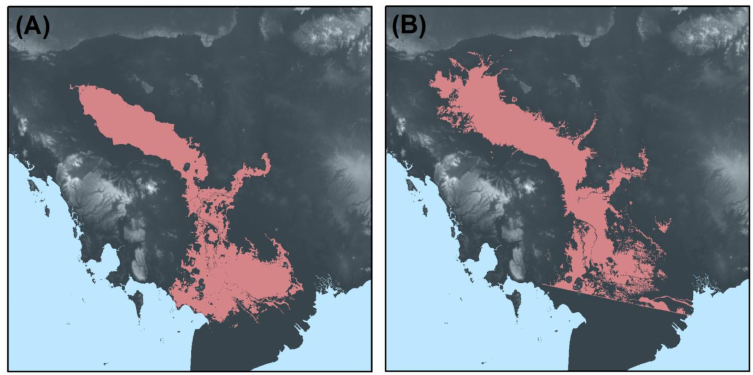
Figure A1. Comparison of inundation extent between the MIKE11 hydrodynamic simulation of a large flood event ( A ) and the Advanced Synthetic Aperture Radar (ASAR)-detected flooding ( B ).